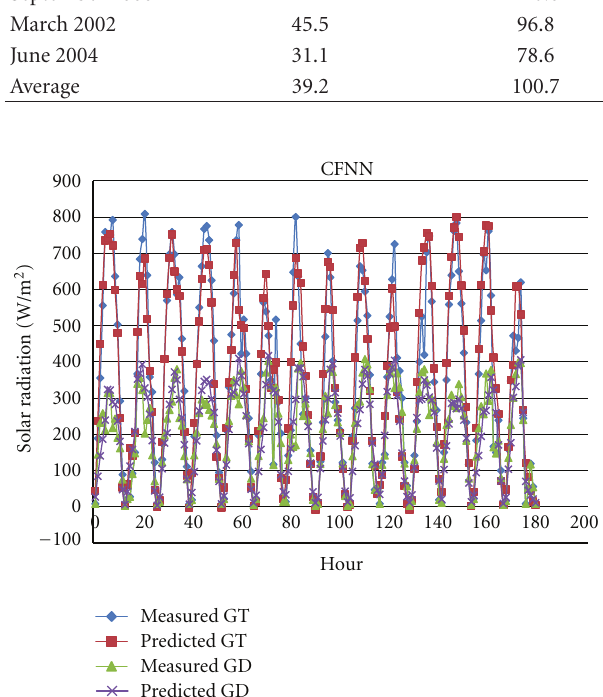
Figure 7: Solar radiation prediction results using CFNN.